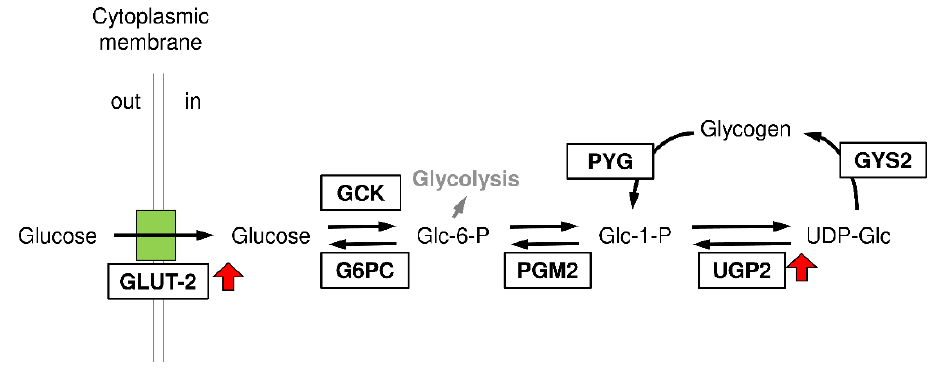
Figure 6. Cellular pathways of glycogen synthesis stimulation by taurine. G6PC: Glucose 6-phos- phatase; GCK: Glucokinase; PGM2: Phosphoglucomutase 2; UGP2: UDP-glucose pyrophosphory- lase 2; GYS2: Glycogen synthase 2; PYG: Glycogen phosphorylase . Table 1. Differential expressed genes in the liver of taurine-treated mice identified by microarray analysis .